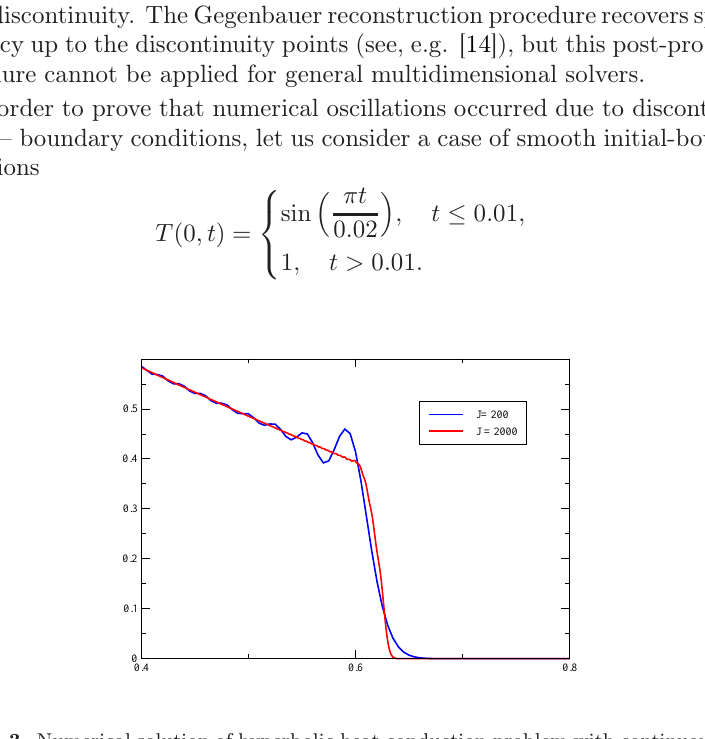
Figure 3. Numerical solution of hyperbolic heat conduction problem with continuous initial and boundary